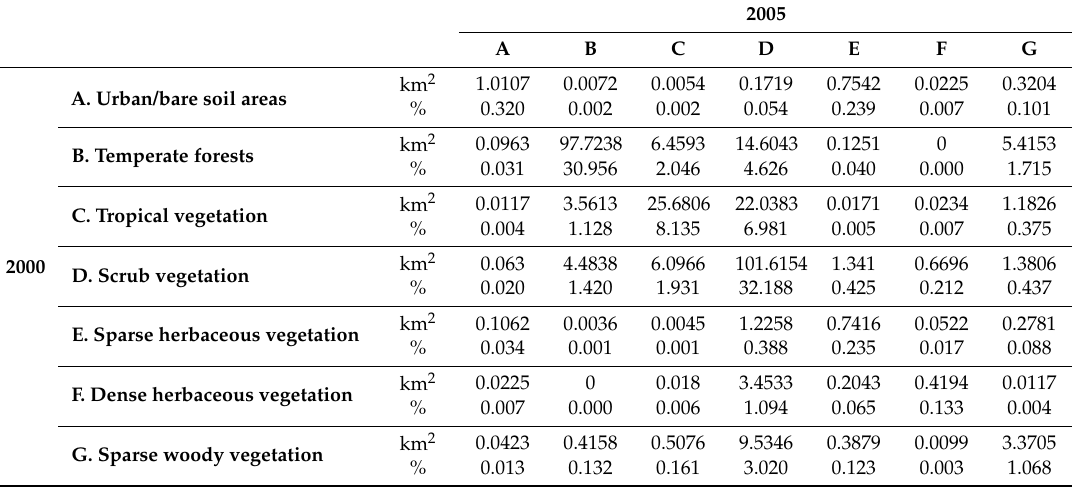
Table 13. Matrix of land use-cover changes from 2000 to 2005, in Natural Protected Area Altas Cumbres (NPAAC). Victoria, Tamaulipas,